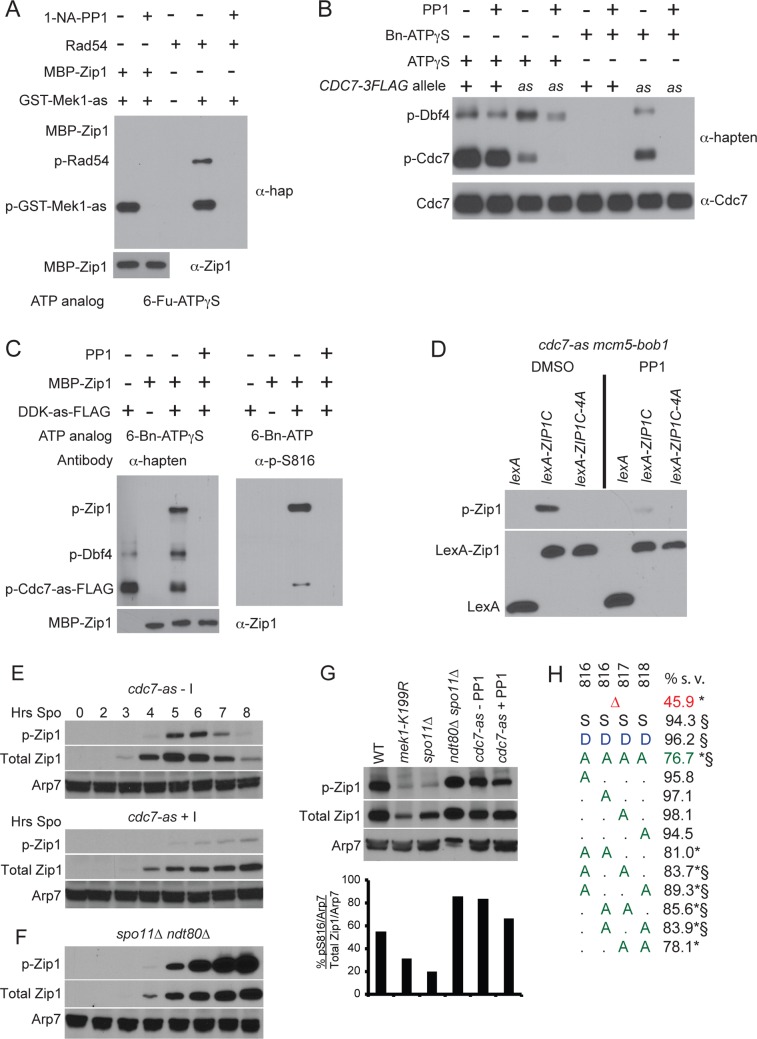
Phosphorylation of Zip1-S816 in vitro and in vivo.(A) Kinase assays using GST-Mek1-as (GST: Unitprot P0A9D2) partially purified from meiotic yeast cells and MBP-Zip1 (MBP: Unitprot P19642) or Rad54 as indicated with the ATP analog, 6-Fu-ATPγS. Phosphorylated proteins were detected using the semisynthetic epitope system with α-hapten (α-hap) antibodies [53]. The presence of MBP-Zip1 was confirmed using antibodies against total Zip1 (α-Zip1). The 1-NA-PP1 inhibitor concentration was 1 μM. (B) Kinase assays comparing autophosphorylation of DDK-FLAG and DDK-as-FLAG partially purified from meiotic yeast cells in the presence of ATPγS or the ATP analog, 6-benzyl (Bn)-ATPγS. The PPI inhibitor was used at a concentration of 20 μM. (C) DDK-as-FLAG kinase assays with MBP-Zip1. Left panel: 6-Bn-ATPγS was used with α-hapten antibodies to detect phosphorylated proteins by the semisynthetic epitope system. Right panel: 6-Bn-ATP was used with α -phospho-S816 antibodies to specifically detect Zip1 p-S816. (D) Zip1-S816 phosphorylation in vegetative cells with and without DDK-as kinase activity. The haploid cdc7-as mcm5-bob1 strain, NH2309-6-3, was transformed with plasmids constitutively expressing lexA, lexA-ZIP1C
749-875, or lexA-ZIP1C
749-875
-4A and grown in the presence of either dimethylsulfoxide (DMSO) or 15 μM PP1. Extracts were probed with α-pS816 or α-lexA antibodies to detect Zip1 p-S816 and LexA, respectively. (E) Zip1 S816 phosphorylation in meiotic cells with and without DDK-as kinase activity. The cdc7-as3-9myc (called cdc7-as for short) diploid, NH2322, was transferred to Spo medium and the culture split in half at the 0 hour time point. To one half, DMSO was added (-I) and to the other a final concentration of 20 μM PP1 was added. Time points were collected and protein extracts assayed for the total amount of Zip1 as well as Zip1 p-S816. (F) Zip1 S816 phosphorylation in an ndt80Δ spo11Δ (NH2337) diploid. (G) Composite gel using extracts from time points with the highest amount of Zip1 from the indicated strains were run on the same gel and probed for total Zip1, p-S816, and Arp7. Quantification was performed as in Fig 6E. (H) Spore viability (% s.v.) of different ZIP1 mutant alleles. Δ = zip1Δ; A = alanine, S and “.” = serine, D = aspartic acid. * and § = significantly different from WT and zip1-4A, respectively. See also S1 Table.